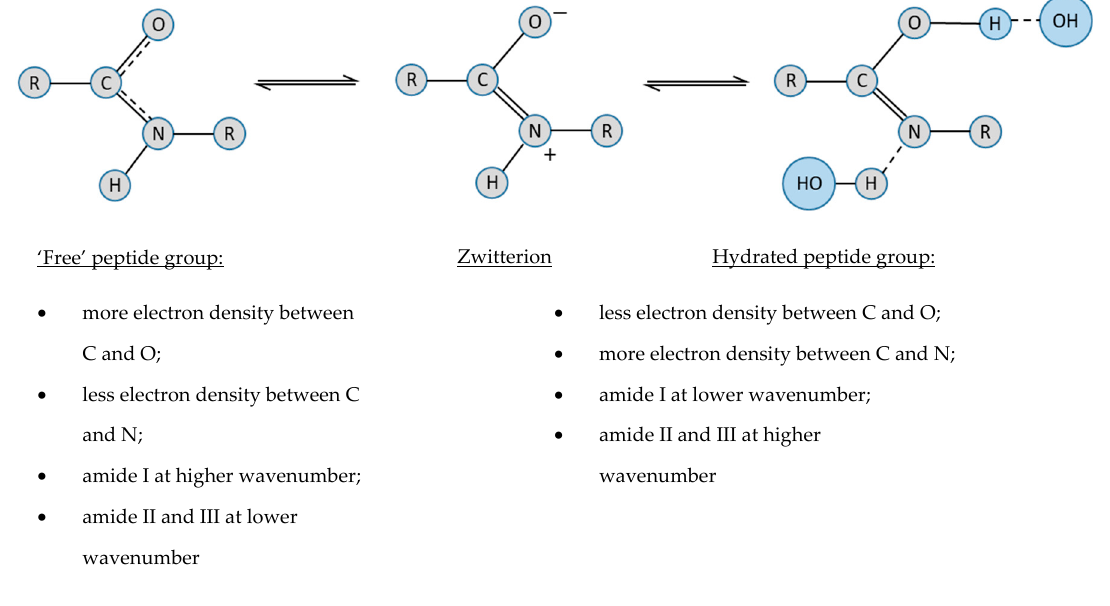
Figure 6. Valence band formalism to describe the changes in electron density around the peptide group in the zwitterionic form (centre) or due to hydration (right): R indicates a methyl group in NMAc or the rest of the chain in a protein, solid lines indicate complete bonds, dashed lines indicate partial and H-bonds.